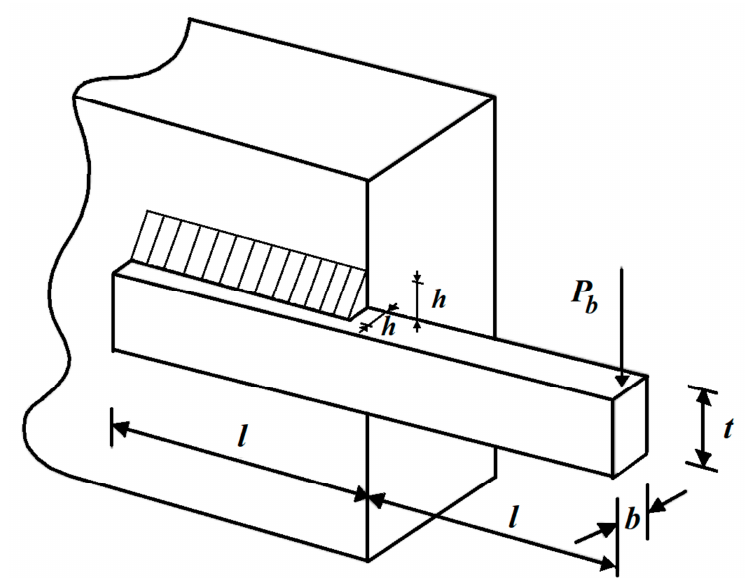
Figure 12. Schematic of the welded beam design.